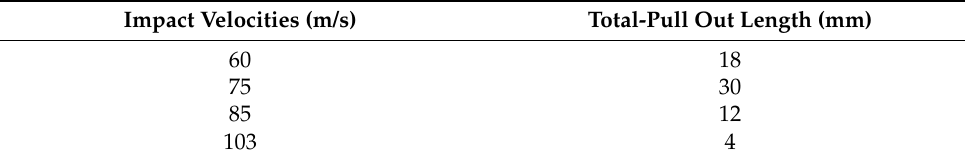
Table 4. Total pull-out length for SMA/GFRP specimens at different impact velocities.